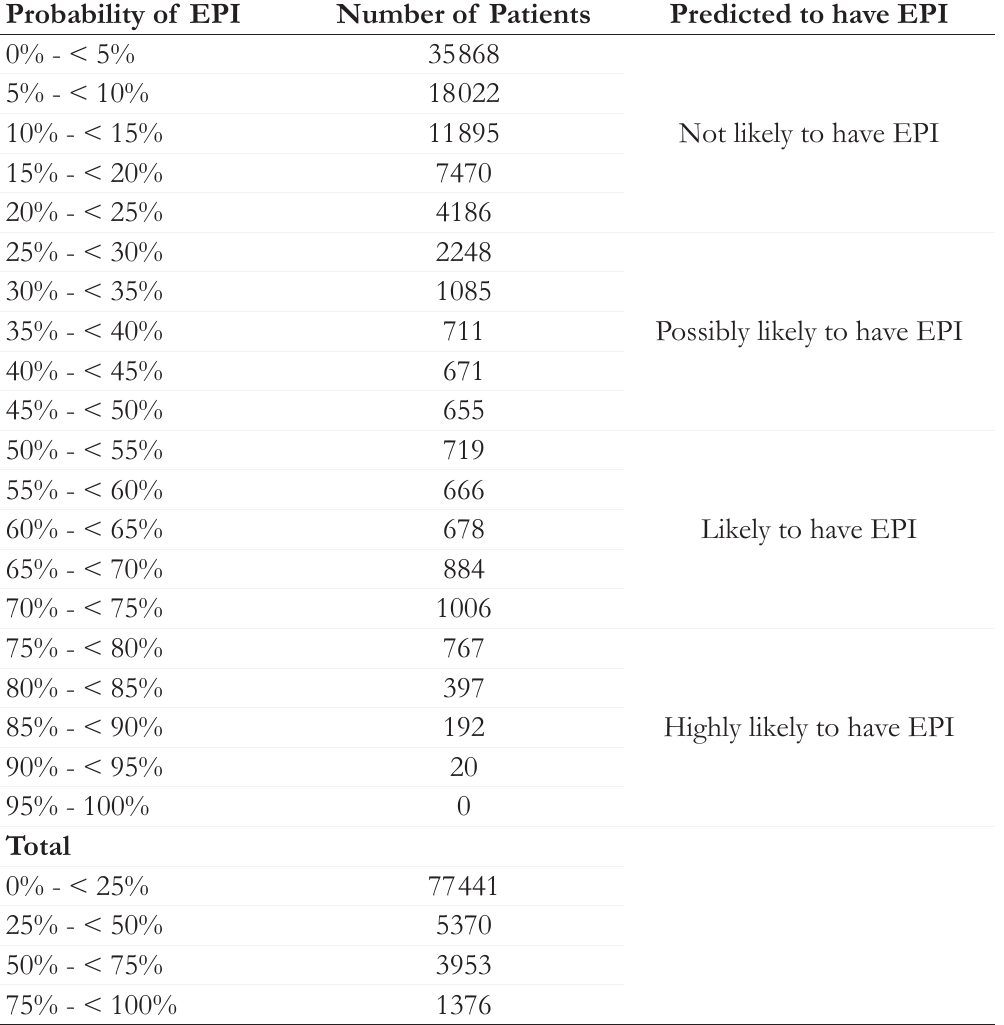
Table 5. Probability of EPI Assigned to Each Patient by Model 3 Probability of EPI Number of Patients Predicted to have EPI 35